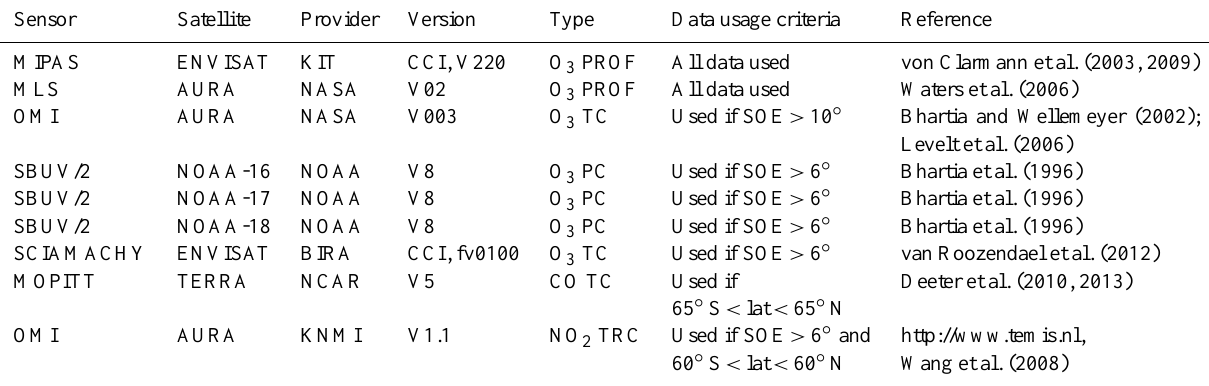
Table 1. Atmospheric composition satellite retrievals that were used in CIFS-AN. PROF denotes profile data, TC total columns, TRC